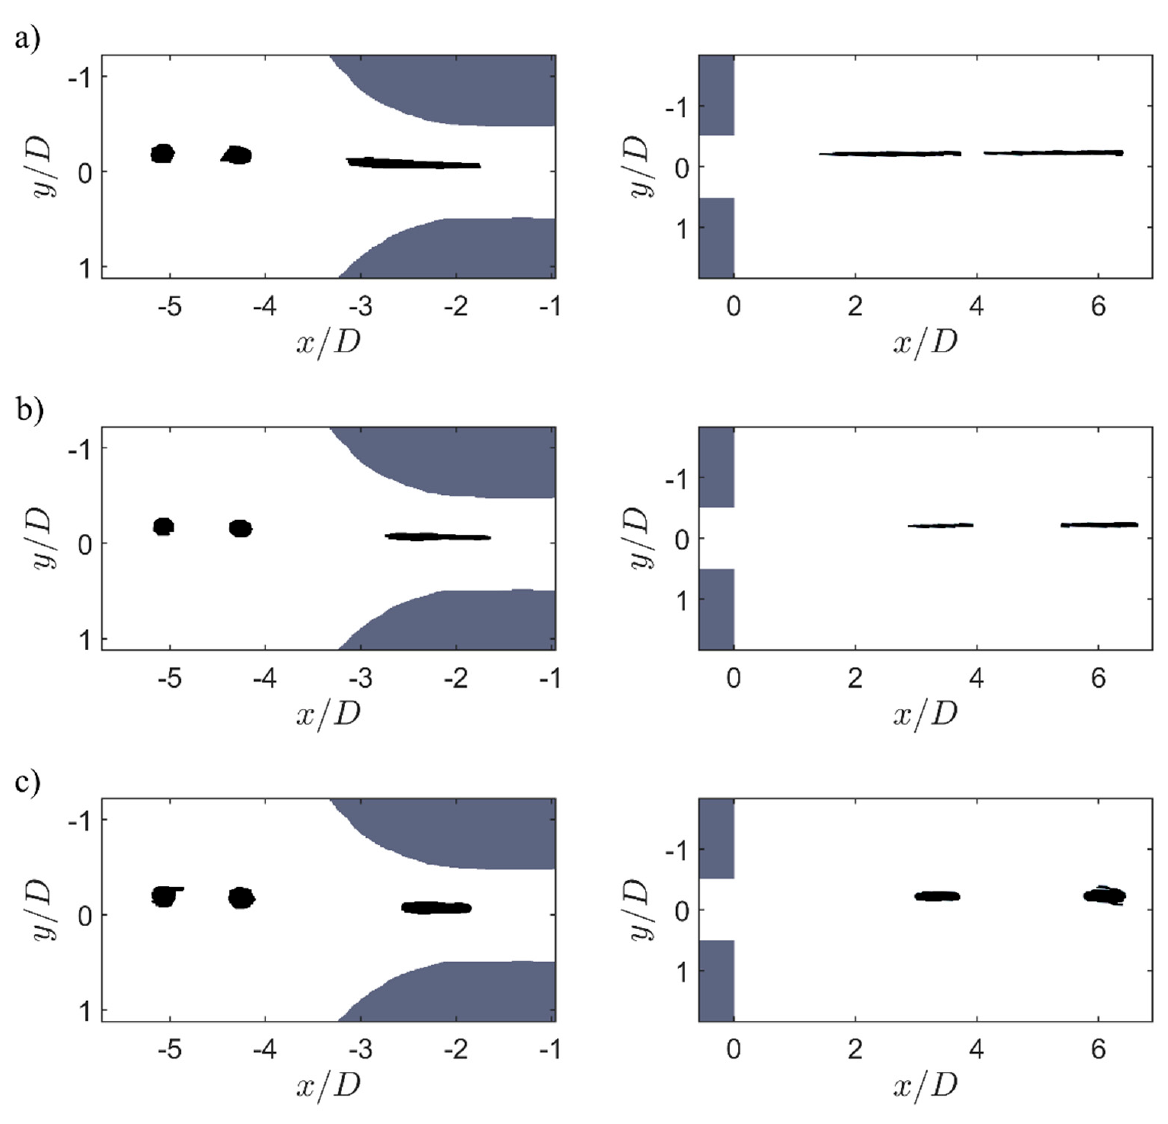
Figure 10. Timeseries of droplet deformations at different viscosity ratios at a Reynolds-number of Re = 2000: ( a ) low viscous oil λ = 0.3, ( b ) medium viscous oil λ = 3.0 and ( c ) high viscous oil λ = 10.8 .